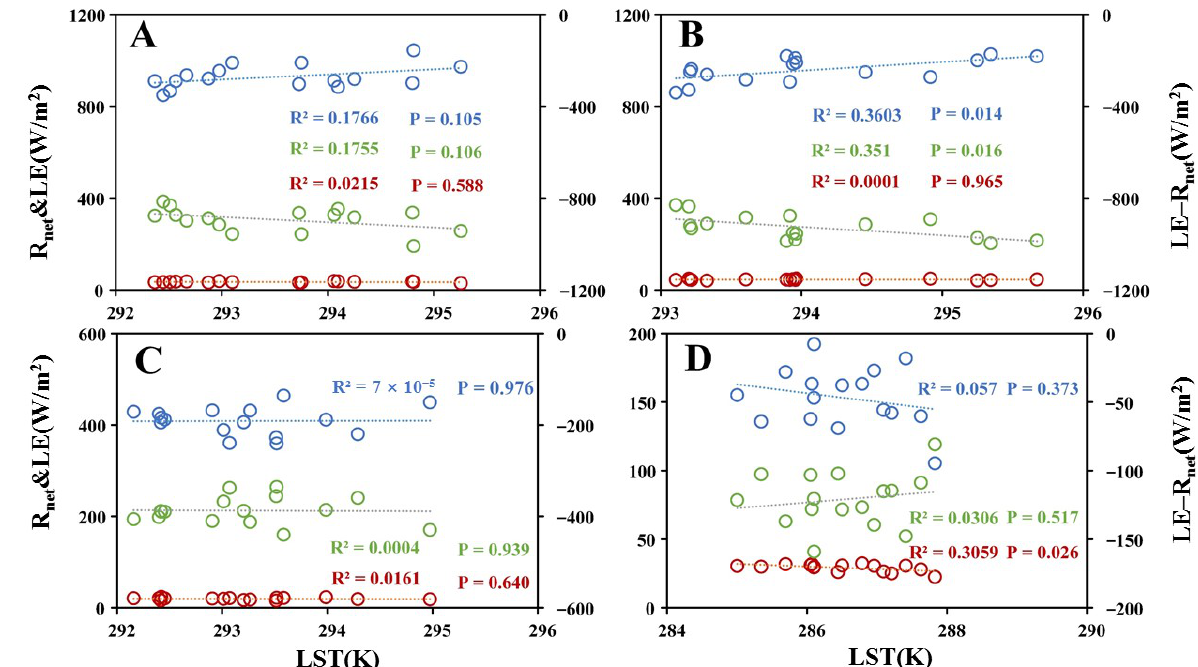
Figure 19. Correlation between LST and R net , LE, and LE − R net under five land types (blue dots and lines represent scatter plots of LST and R net , red dots and lines represent scatter plots of LST and LE, and green dots and lines represent scatter plots of LST and LE − R net . (( A ) Jinan City, ( B ) Zhengzhou City, ( C ) Lanzhou City, ( D ) Xining